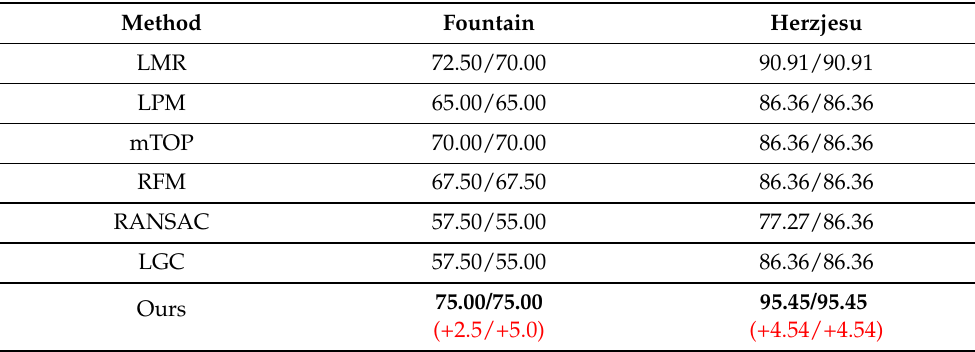
Table 4. Relative pose estimation accuracy (%) on Daisy. Each column represents a scene. Each cell represents the accuracy of rotation estimation (left) and the accuracy of translation estimation (right). The estimation of an image pair is successful when the angle error is under a certain threshold (10 ◦ ). The best results are in bold. The red numbers in the brackets indicate the improvement between the best and the second best